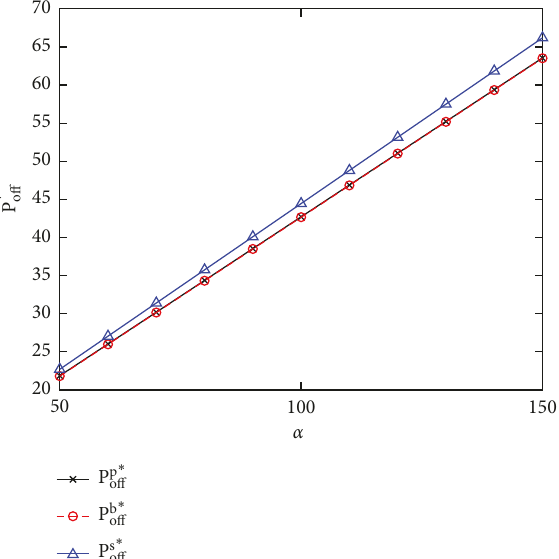
Figure 8: Impact of change in α on offline